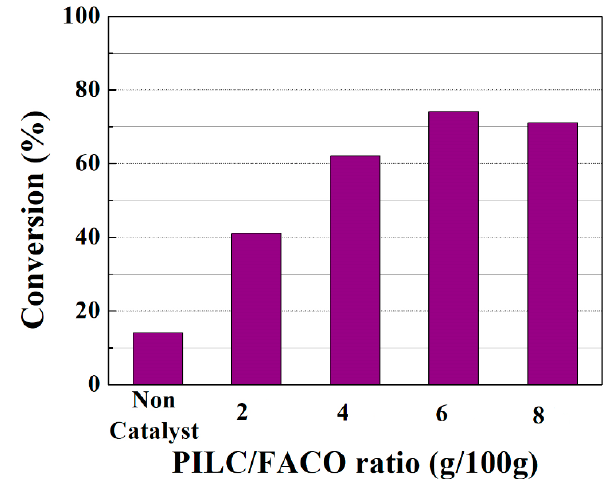
Figure 6. Influence of the PILC/FACO ratio (g/100 g) on the FACO to esters conversion in the esterification reaction of FACO with EH. Catalytic conditions: EH:FACO molar ratio of 1.5, reaction temperature: 50 °C, reaction time: 6 h.